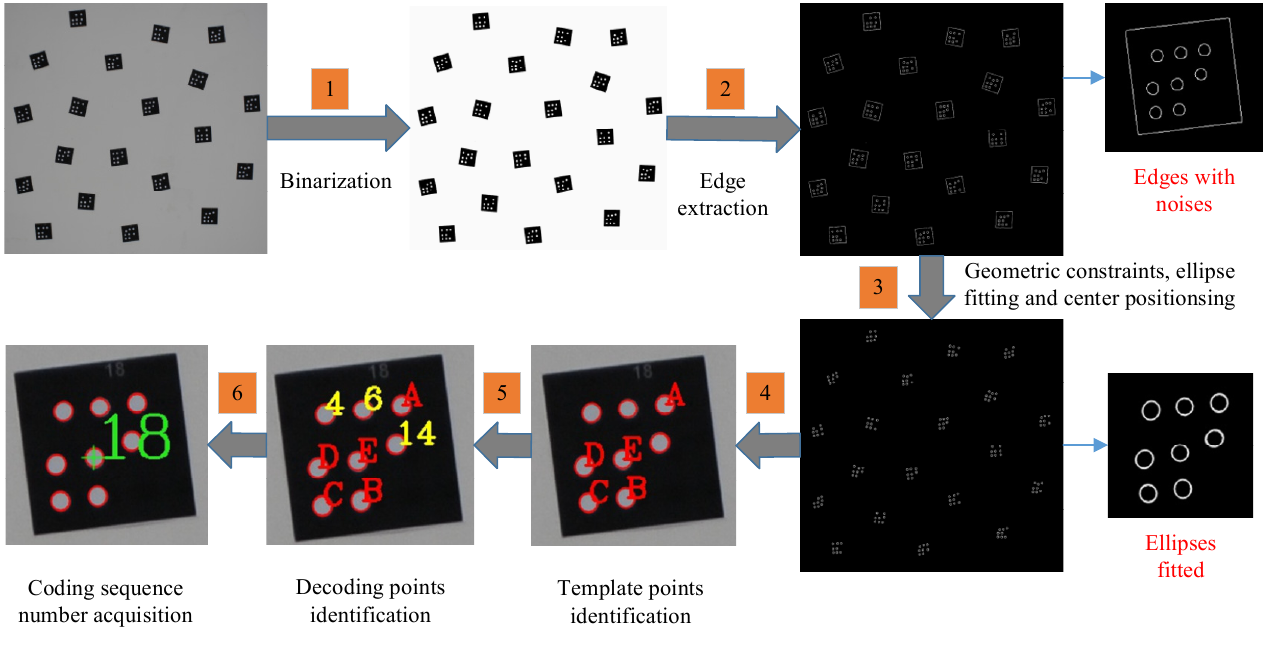
Figure 5. Procedure of